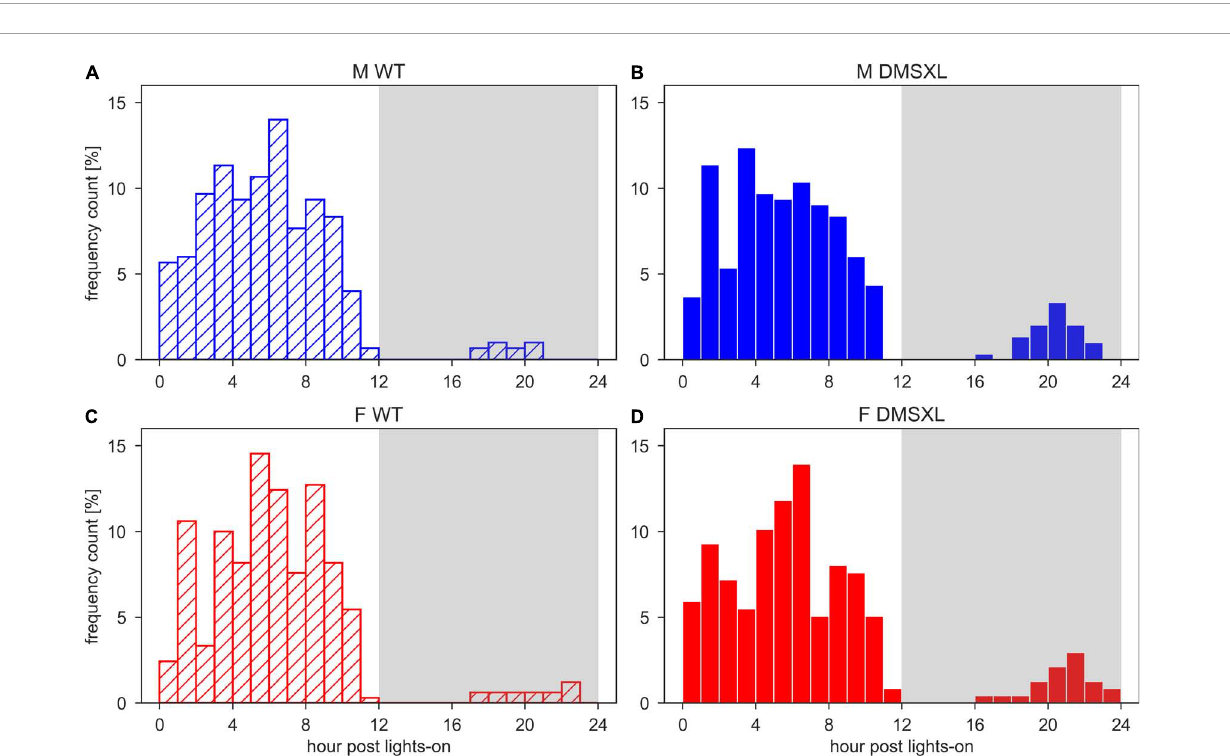
FIGURE4 Histograms of the time of the least active hour. Time of the day of the least active hour per each cage and each day of the 5 weeks of experiment in wild-type (WT) male (A) , DMSXL male (B) , WT female (C) , and DMSXL female (D) mice. N of cages per group: M WT = 10; M DMSXL = 10; F WT = 11; F DMSXL =